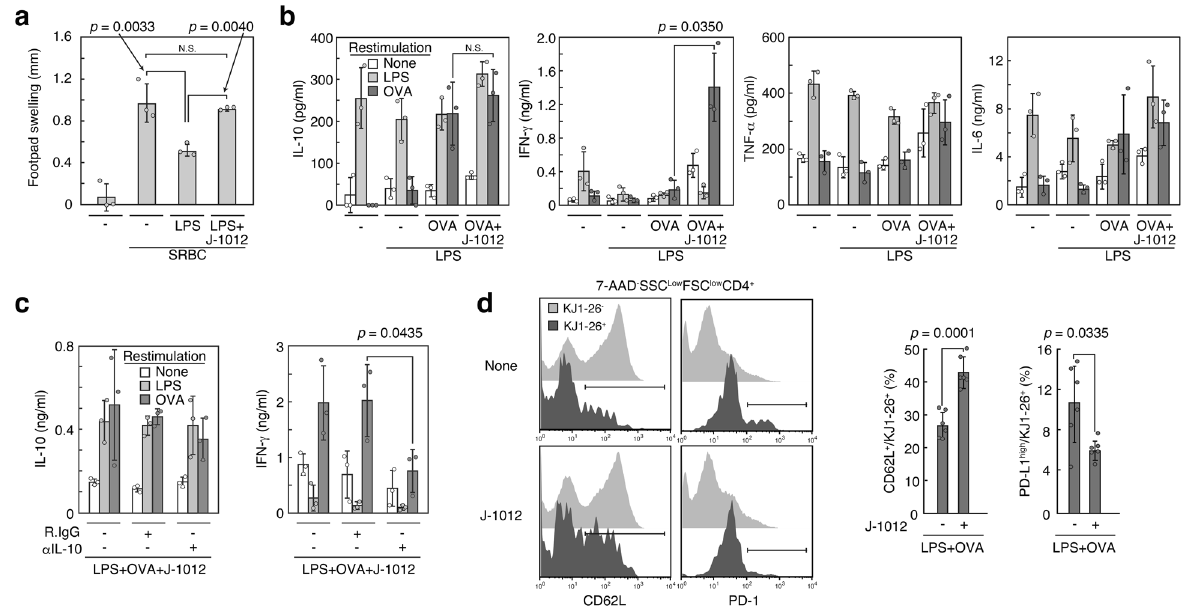
Fig. 4 Amelioration of hypo-immunoreactivity by J-1012 N-glycan. a Recovery of delayed-type hypersensitivity in mouse footpad by J-1012 N-glycan. b , c Analyses of cytokine production by splenocytes from mice after 2 weeks of sepsis induction with i.v injection of OVA, J-1012 N-glycan and LPS without ( b ) or with anti-IL-10 mAb ( c ). The splenocytes were restimulated as described for 4 days. d Expression of CD62L and PD-1 of transferred DO11.10T cells (CD4 + KJ1-26 + ) (Supplementary Fig. 10) from mice after 2 weeks of sepsis induction with OVA, LPS and J-1012 N-glycan. The experiment was repeated twice, and compiled results are shown (right panels) ( n = 6). a – c Data are expressed as the mean±SD and are representative of at least two independent experiments ( n = 3). p value was determined by unpaired two-tailed Student ’ s t -test. N.S., not signi fi cant ( p >0.05). R.IgG, control rat IgG. SRBC sheep red blood